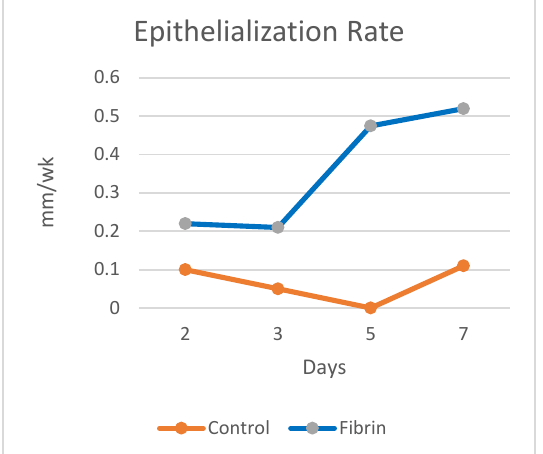
Figure 5. The average epithelialization rate (cm/wk) of the fibrin-treated meshed grafts and controls for the first seven days [56].